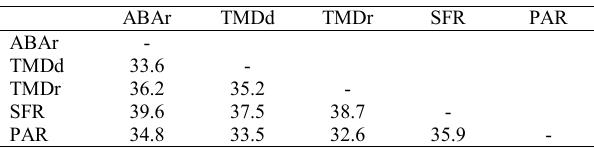
Table 9. Chord genetic distance among sampling of Prochilodus costatus . Values in %. ABAr = rio Abaeté at rainy season; PAR = rio Paracatu lagoons; SFR = rio São Francisco lagoons; TMDd = Três Marias Dam at dry season; TMDr = Três Marias Dam at rainy season.